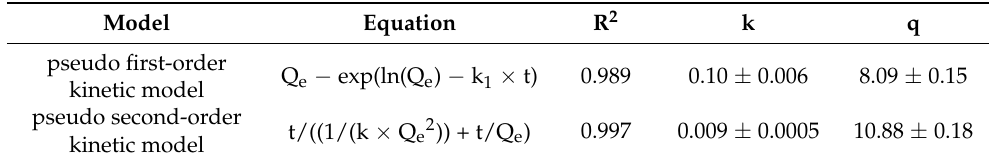
Figure 6. Swelling kinetic curve of the hydrogel. Table 4. Model fitting parameters.